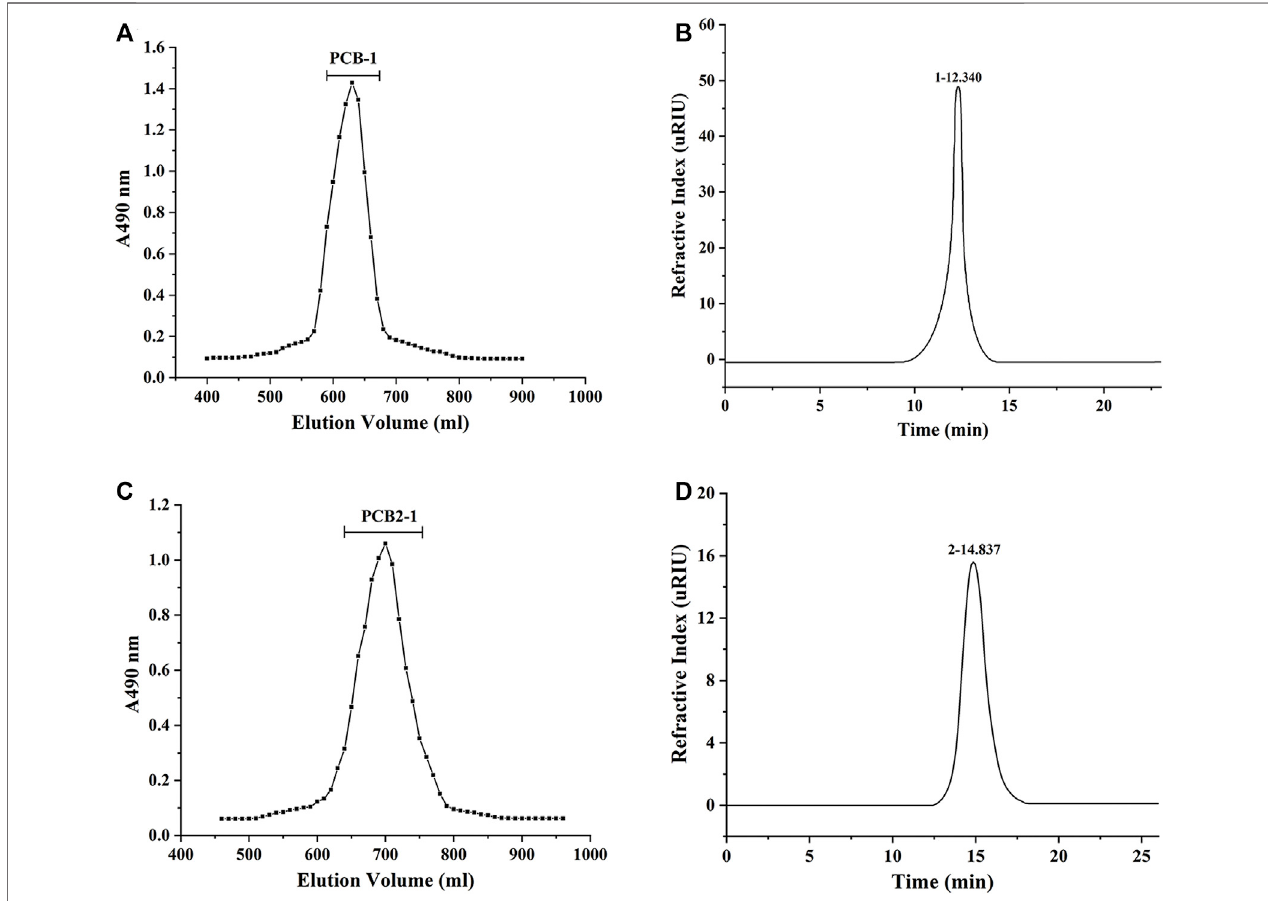
FIGURE 2 | Molecular weight (Mw) determination of polysaccharides isolated from P. cablin : (A) HPGPC analysis of PCB-1; (B) HPLC analysis of PCB-1; (C) HPGPC analysis of PCB2-1; (D) HPLC analysis of PCB2-1.